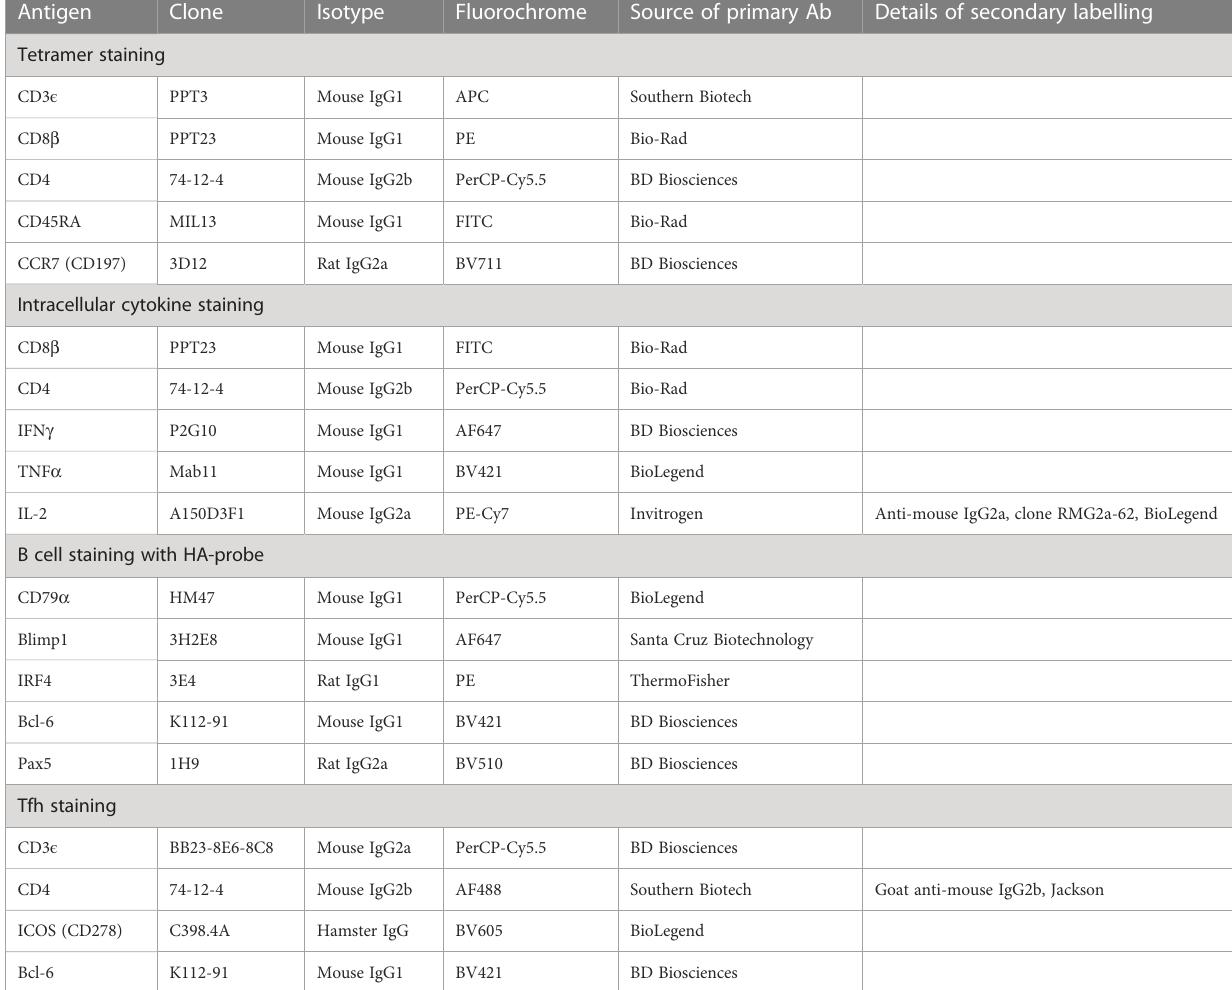
TABLE 1 Antibodies used: Antigen Clone Isotype Details of secondary